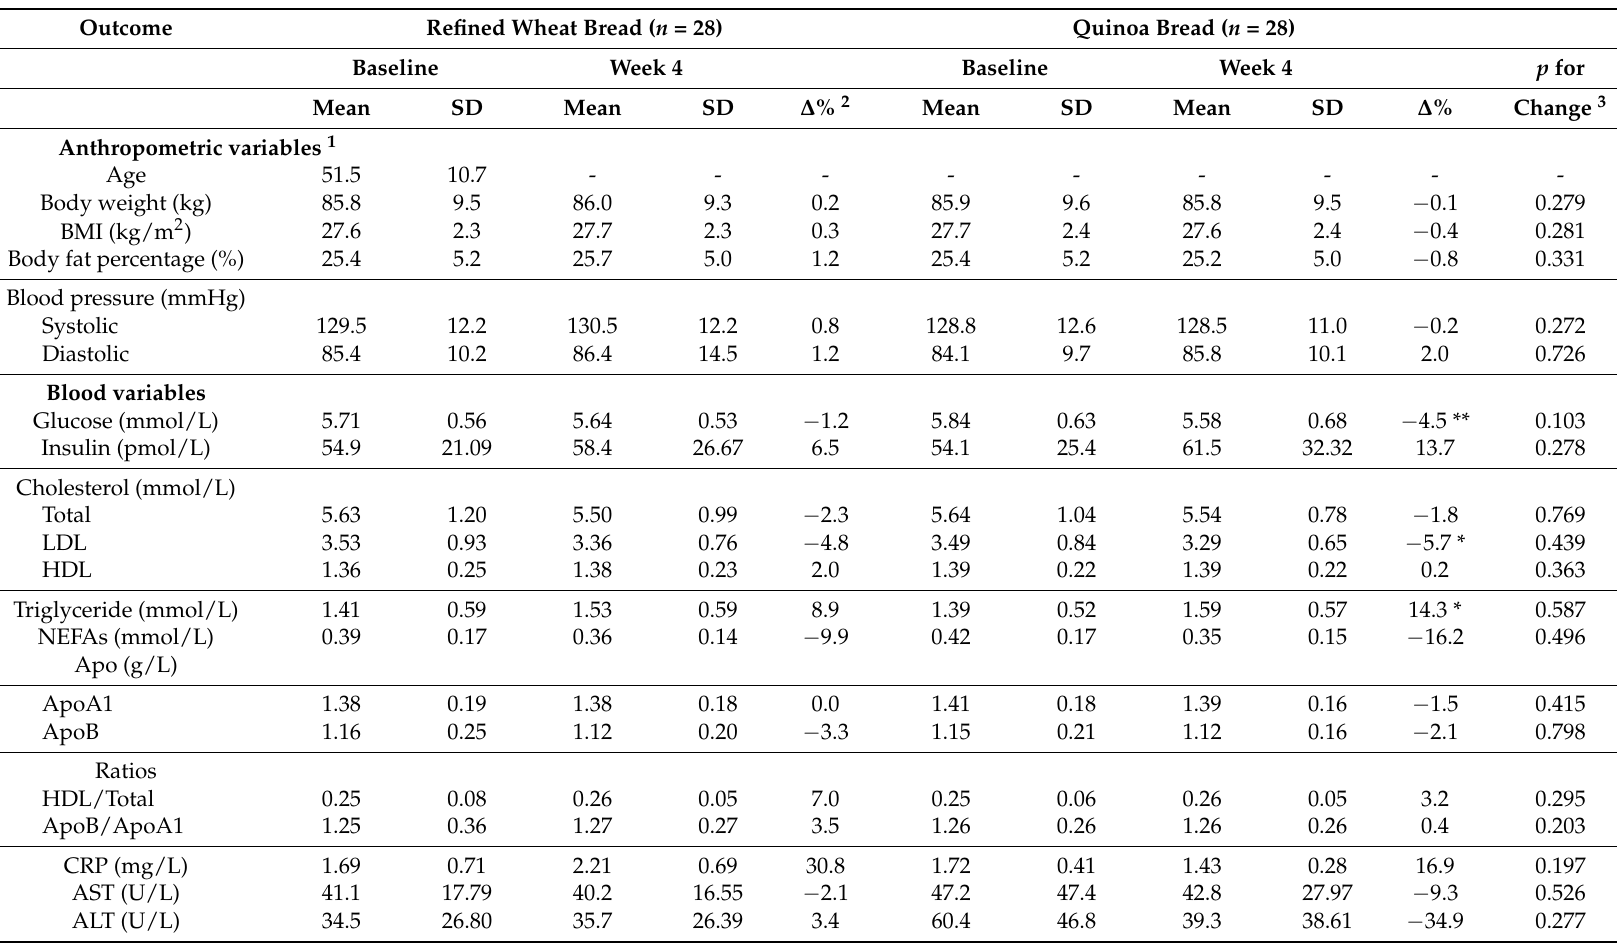
Table 3. Effect of refined wheat and quinoa bread on anthropometry, blood pressure, blood parameters and plasma antioxidant capacity